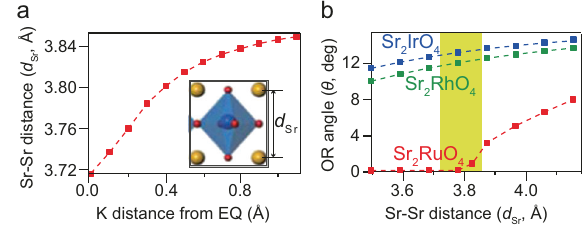
Fig. 4 Vertical Sr – Sr distance as the link between the surface electric potential and OR angle. a DFT calculation results from a – Sr distance as a fi ve-Sr 2 RuO 4 -layer slab. The plot shows the Sr function of the K-layer distance. Inset: enlarged view of an octahedron in the surface Sr 2 RuO 4 layer. Sr – Sr distance ( d Sr ) is de fi ned as the vertical distance between upper and lower Sr atoms. b DFT results for the OR angle as a function of the Sr – Sr distance for bulk Sr 2 RuO 4 , Sr 2 RhO 4 , and Sr 2 IrO 4 . The shaded region marks the actual range over which the Sr – Sr distance varies in a